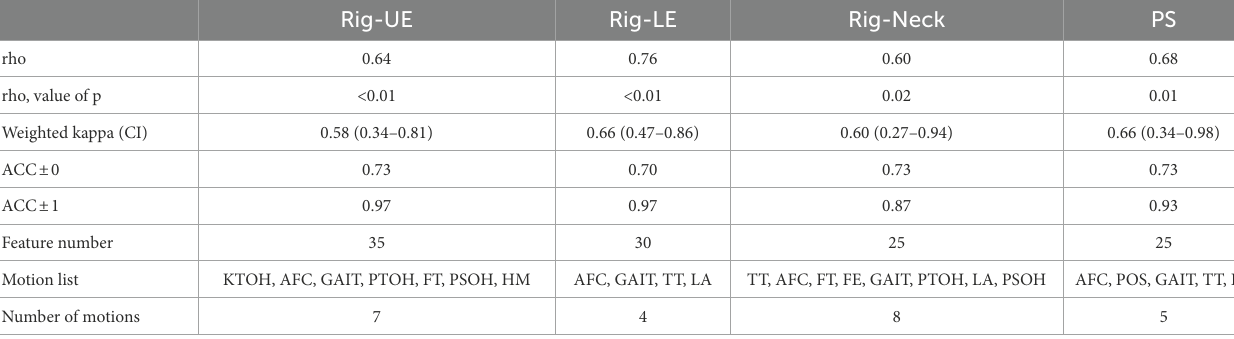
TABLE 2 Performance of four models considering all